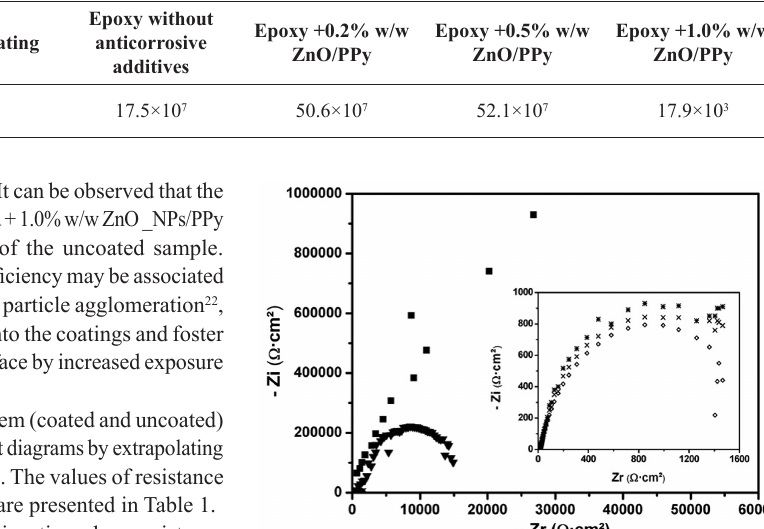
Figure 6. Nyquist diagram for: (◊) uncoated metal; samples coated with epoxy: (▼) without anticorrosive additives, (■) +0.2%, (×) +0.5% and (*) +1.0% w/w ZnO/PPy.